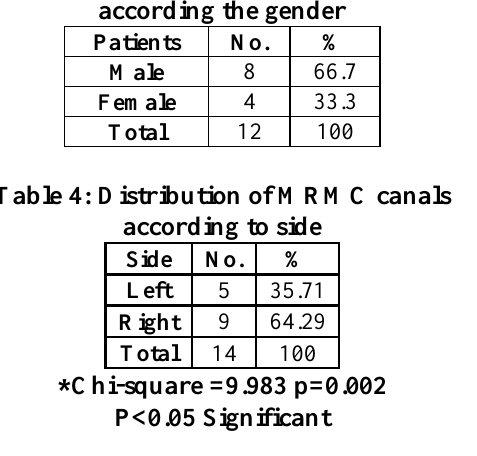
Table 3: distribution of affected sample